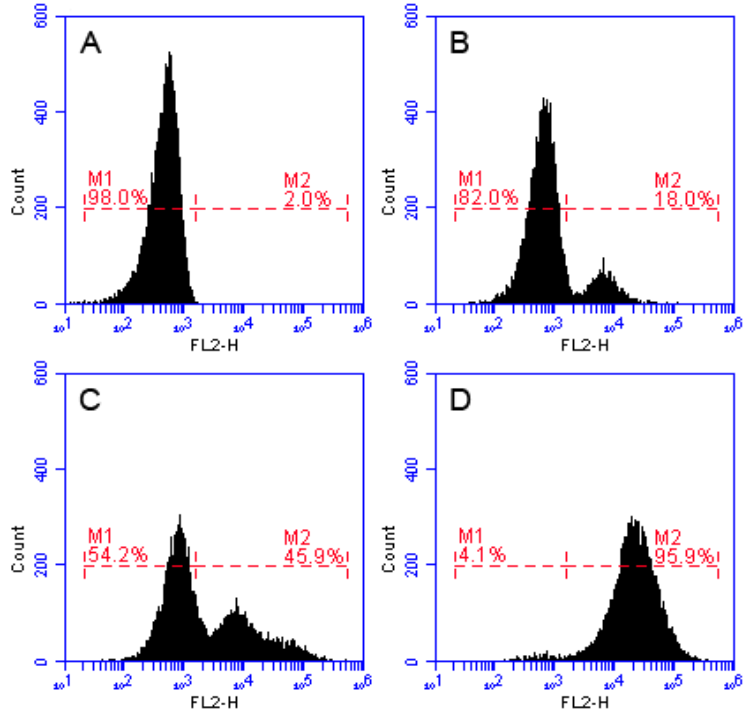
Figure 9. Flow cytometric analysis. The membrane damage of S. aureus treated by peptides was measured by an increase of fluorescent intensity of propidium iodide (PI) at 4 °C for 30 min. ( A ) No peptide, negative control; ( B ) LGH2 at 0.5 × MIC; ( C ) LGH2 at 1 × MIC; ( D ) LGH2 at 2 × MIC.